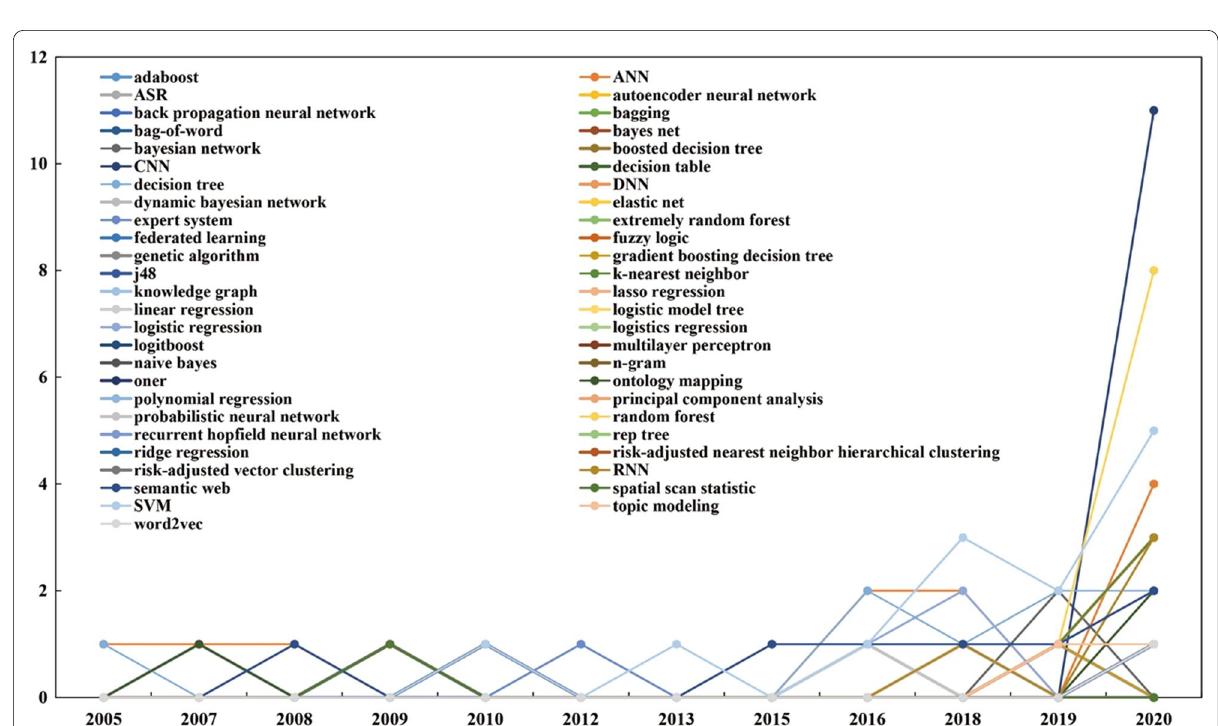
Fig. 9 Distribution of AI technologies by